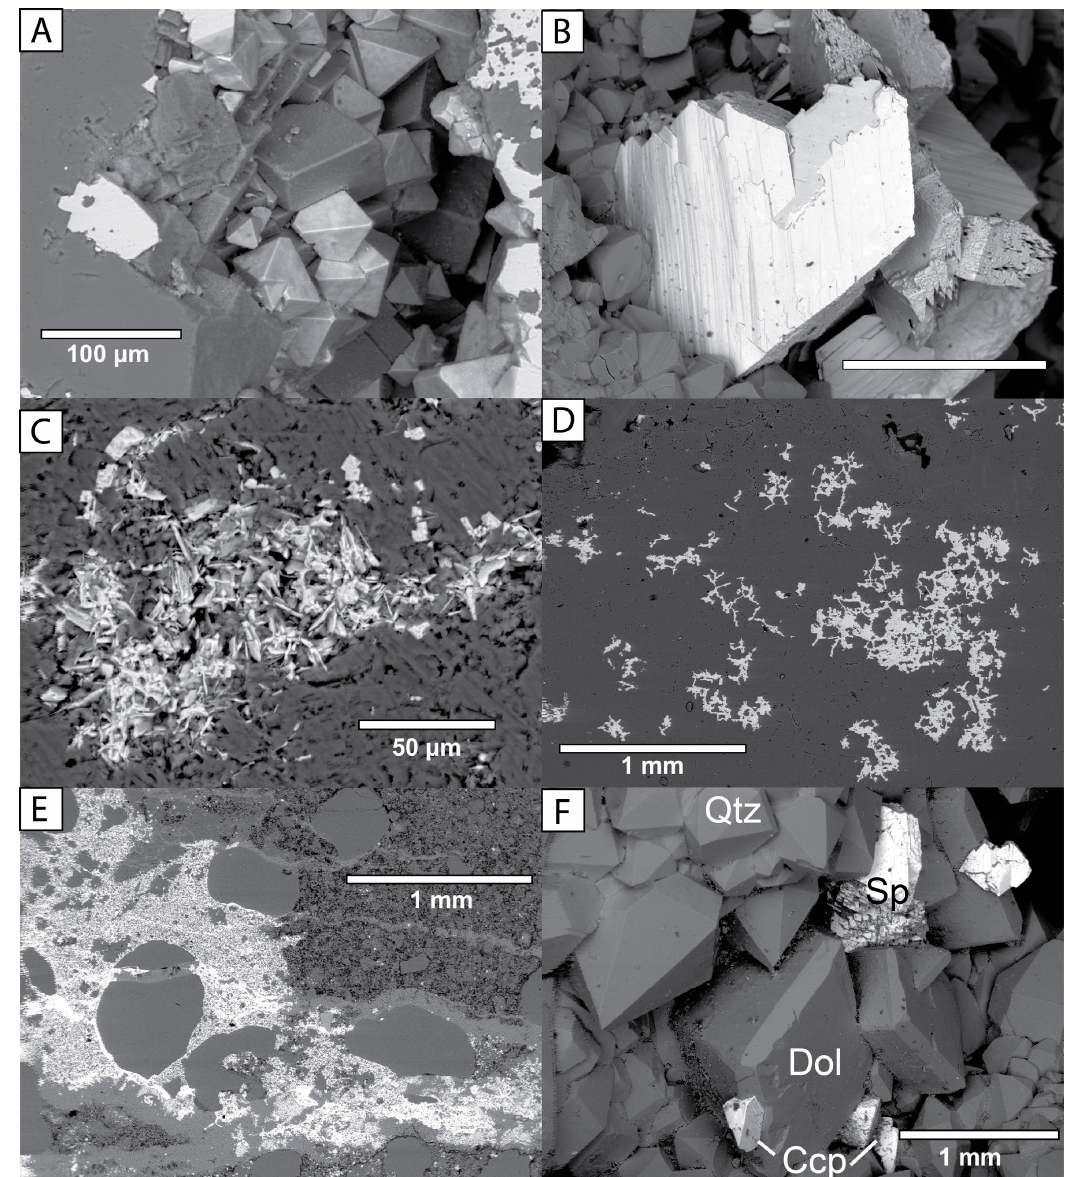
Figure 8. SEM-BSE images of polished sections and vug-filling cements illustrating the character of Mississippi Valley-type mineralization in northeastern Wisconsin: ( A ) Octahedral pyrite is intergrown with dolomite in vug from Locality 59 in Winnebago County (96-WIN-2). Left and right edges are flat, polished surfaces. (B ) Bladed marcasite (bright) on dolomite (gray) from Locality 48 in Shawano County (07-SH-MCK-5). ( C ) Fine bladed marcasite and cubic pyrite intergrown with dolomite from Locality 48 (07-SH-Mck-0) in Shawano County. ( D ) Polished section showing dolomite (gray) and later pyrite (bright) filling pores and replacing parts of the dolomite at Locality 3 in Brown County (07-BN-LQ-1). ( E ) Fracture-filling cements from a quartz sandstone layer in the lower Platteville Formation at Locality 29 in Marinette County (Sample 07-MT-FP-2). Round gray grains are detrital quartz sand. Bright white areas in fracture are pyrite cement, whereas medium gray cements are calcite. Gray spotted areas coprecipitated with pyrite are an unknown authigenic K-Al-Silicate mineral cement, possibly illite or K-feldspar. ( F ) Late dolomite intergrown with chalcopyrite and sphalerite and associated with quartz from Locality 46 (07-NL-45E) in Outagamie County.